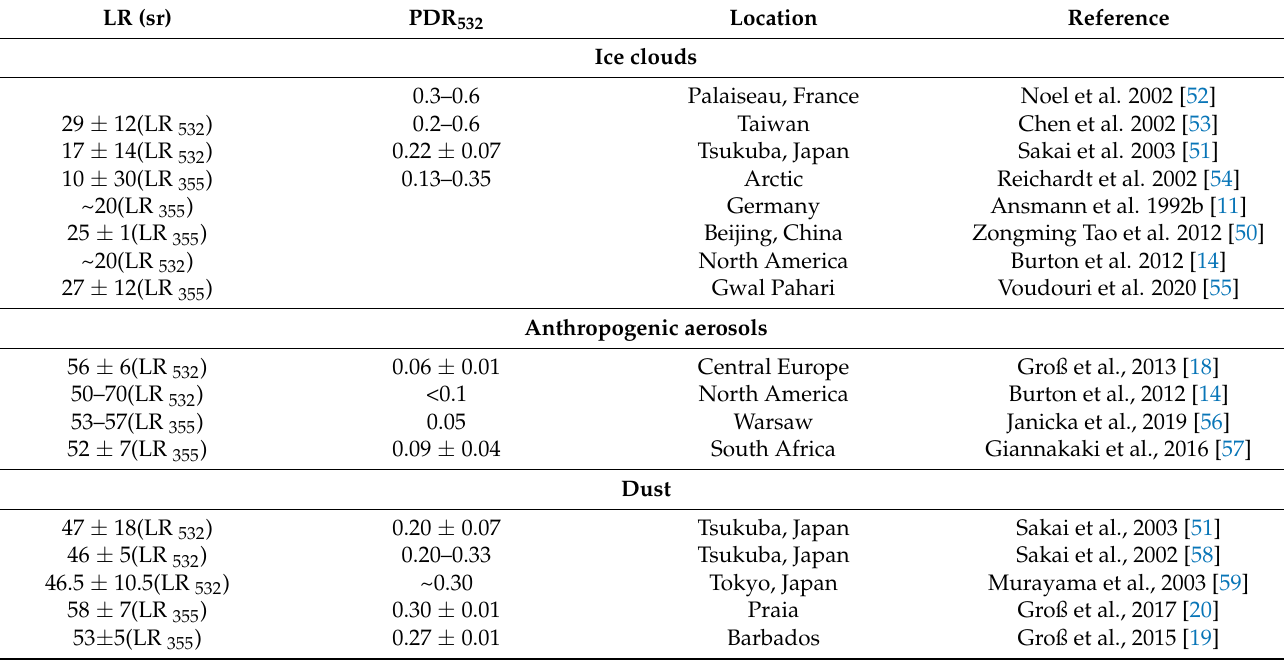
Table 3. Lidar ratio and depolarization ratio for ice clouds, anthropogenic aerosols, and